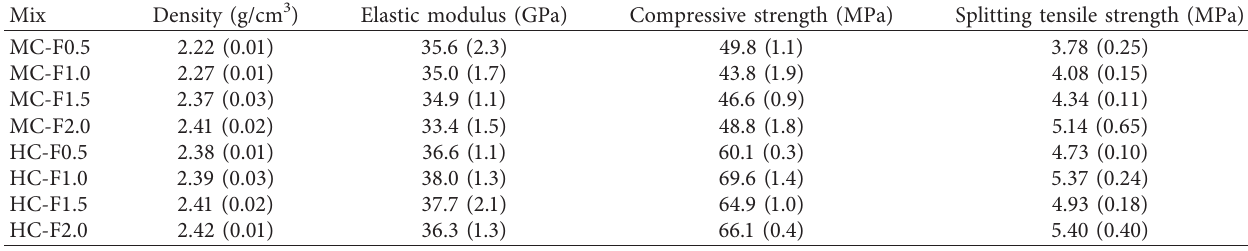
Table 3: Mechanical properties of SFRSCC (standard deviation in parentheses).